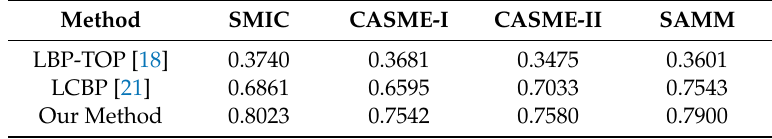
Table 5. The comparison of F1-scores on four spontaneous MEs